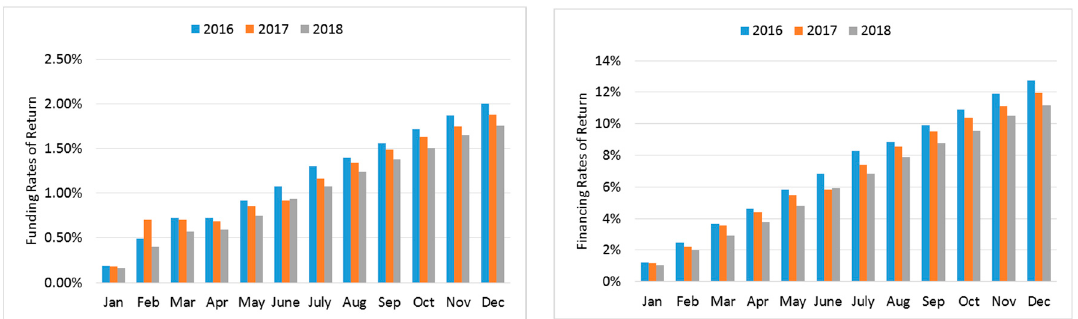
Figure 4. Rates of return for Funding ( left ) and Financing ( right ) funds from Bank C.